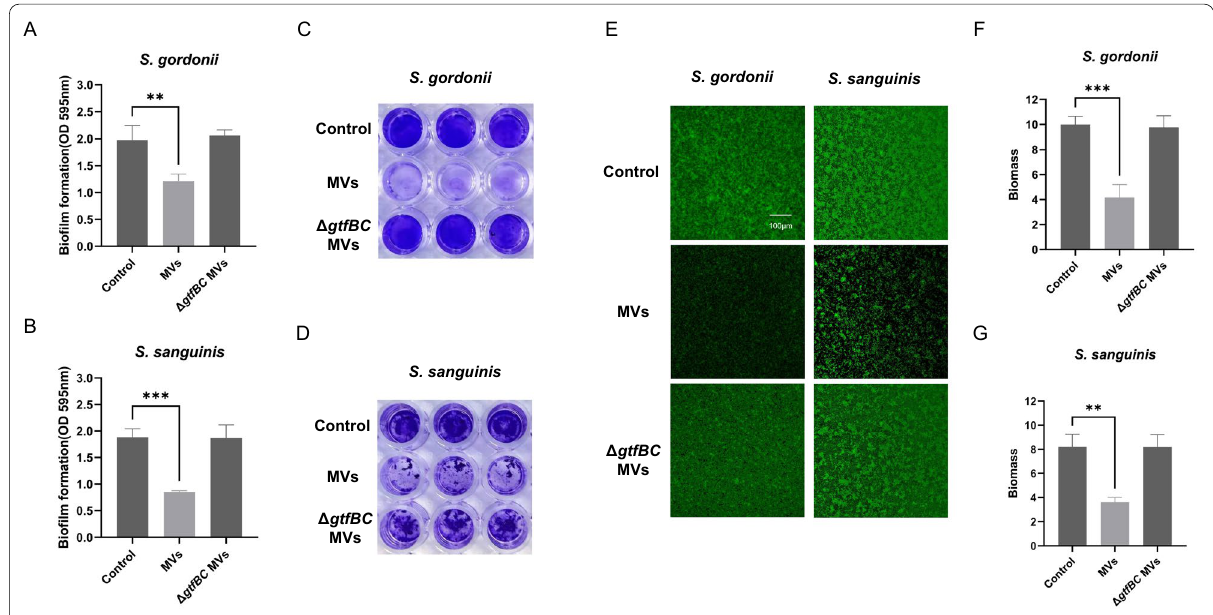
Fig. 1 Effects of MVs on the biofilm formation of S. gordonii and S. sanguinis . A , C Crystal violet staining applied to S. gordonii biofilm. B , D Crystal violet staining applied to S. sanguinis biofilm. E CLSM images of S. gordonii and S. sanguinis biofilms. Images were taken at 20 The biomass of S. gordonii from CLSM images. G The biomass of S. sanguinis from CLSM images. The data are presented as mean independent experiments. (n 3, ** P < 0.01, *** P < 0.001) =